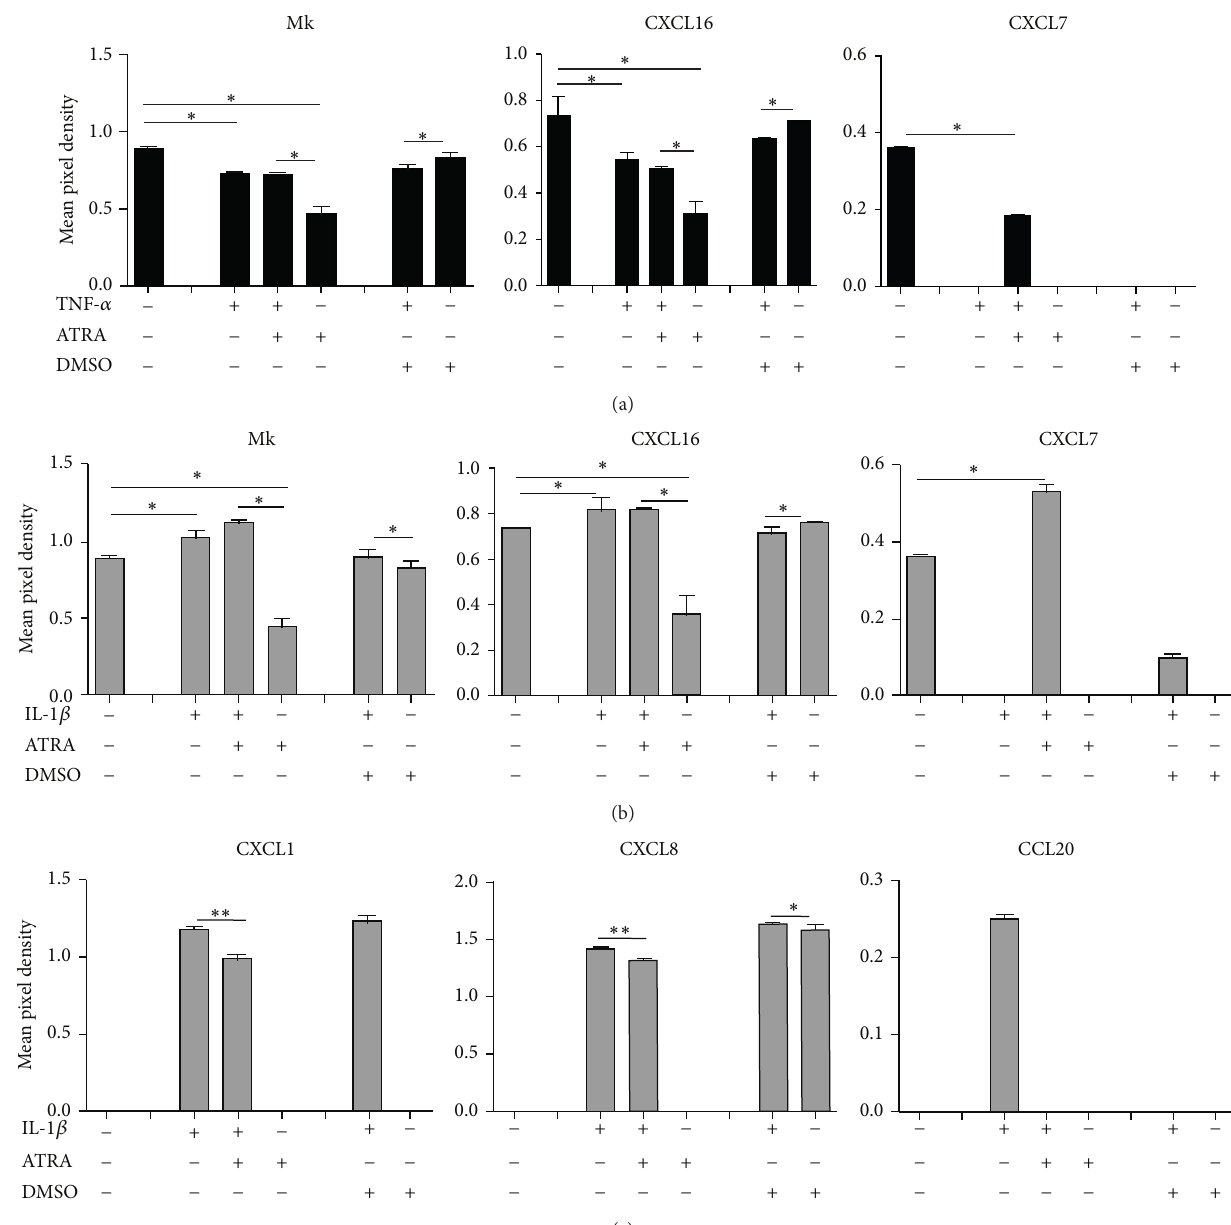
Figure 2: Effects of ATRA on the expression of chemokines in cytokine-stimulated Caco2 cells. Relative expression of chemokines in Caco2 cells, prestimulated by TNF- 𝛼 or IL-1 𝛽 in the presence or absence of ATRA, was determined as described in Figure 1 and was compared